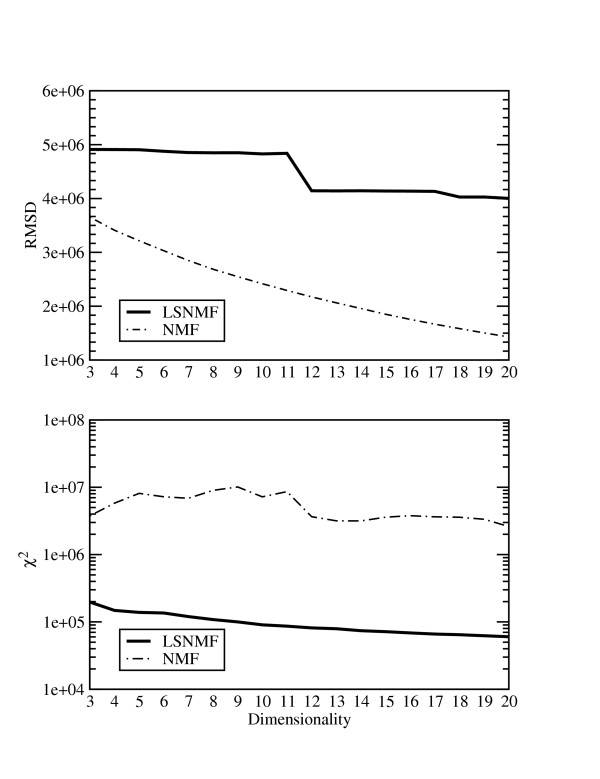
Fits to the Data. The comparison of LS-NMF and NMF for fitting data is shown for the Rosetta Compendium. NMF is based on root mean squared deviation (RMSD) fitting, and as the number of dimensions increases, the fit improves with potential overfitting possible. The χ2 measurement provides the standard measure of fit to the data and shows how the LS-NMF method fits data much better once individual uncertainty measurements are considered.